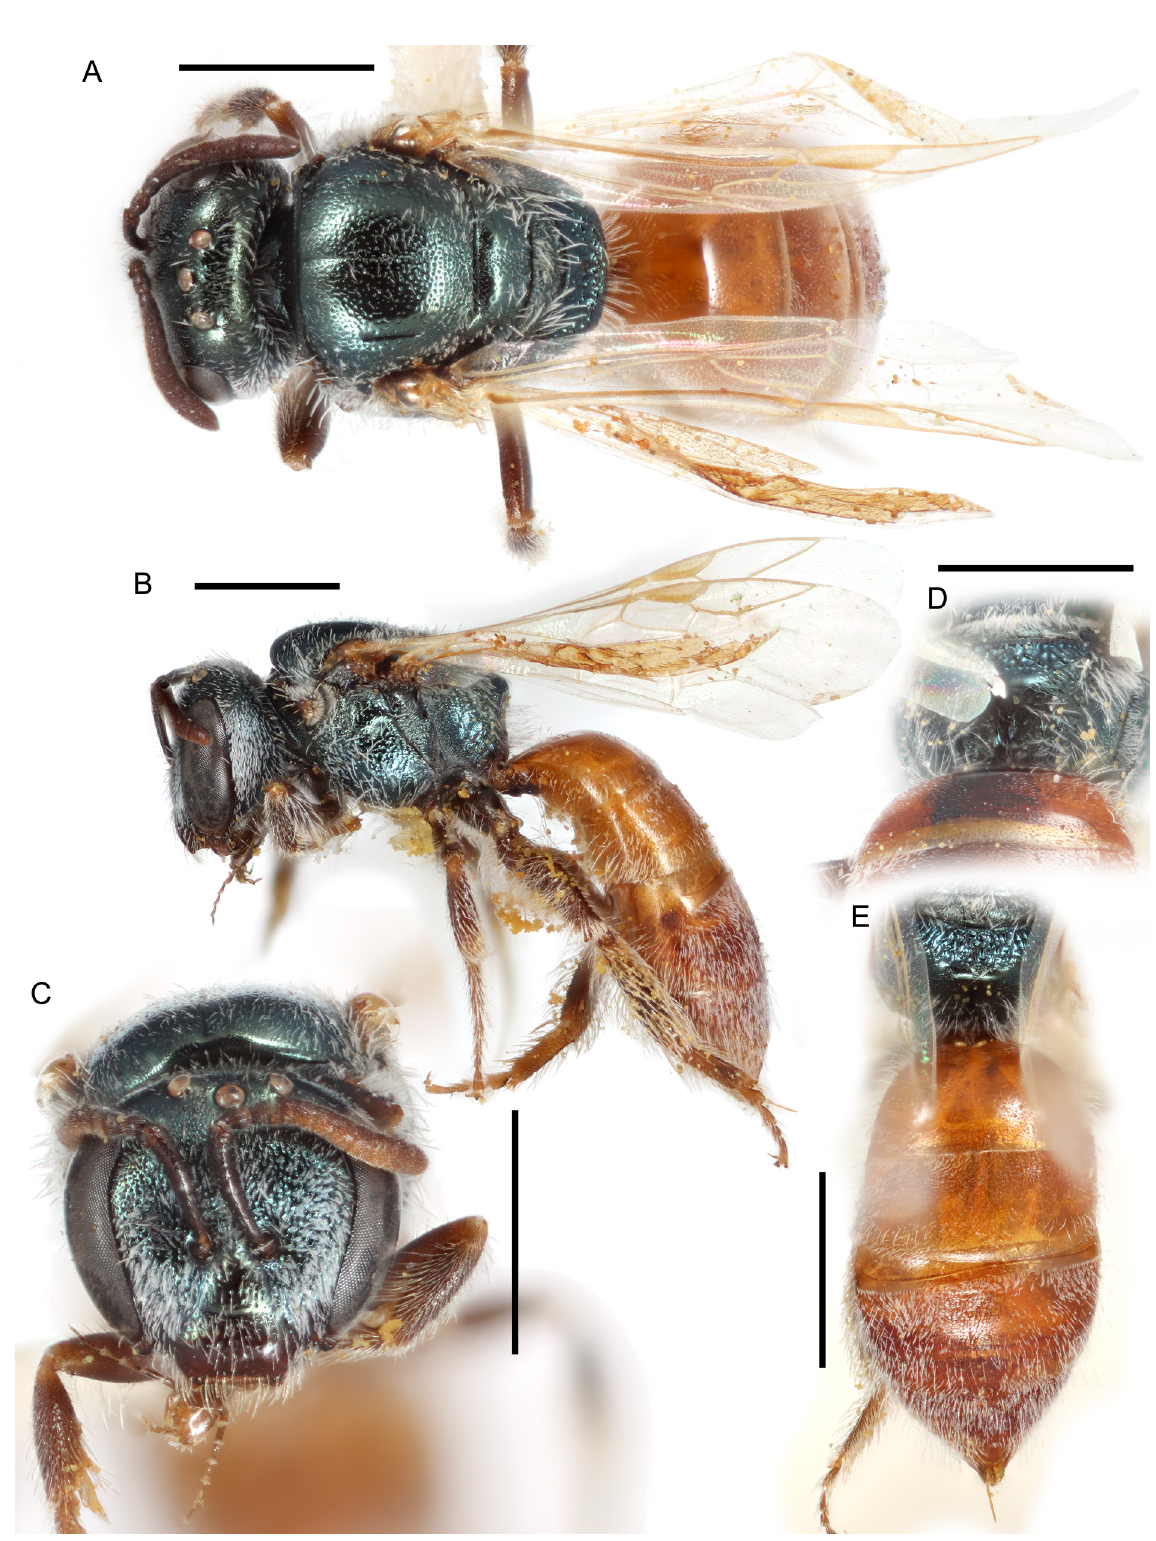
Fig. 25. Lasioglossum ( D. ) clavicorne sp. nov., ♀. A . Dorsal habitus. B . Lateral habitus. C . Face. D . Propodeum. E . Metasoma. Scale bars: 1